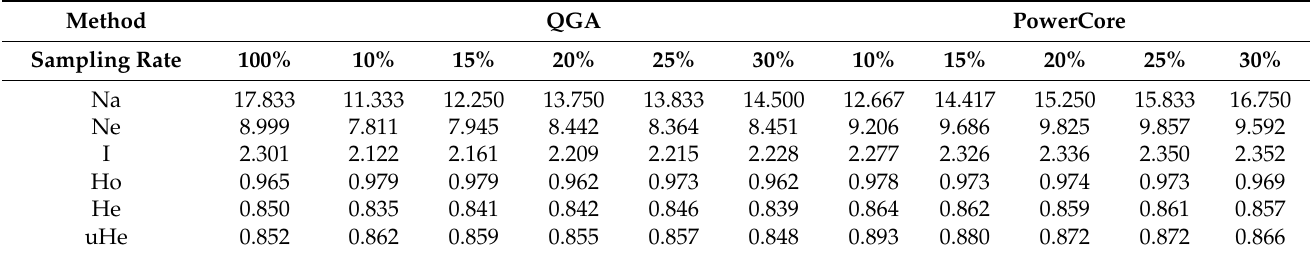
Table 7. Comparison of genetic parameters of C. oleifera core collections based on SSR.